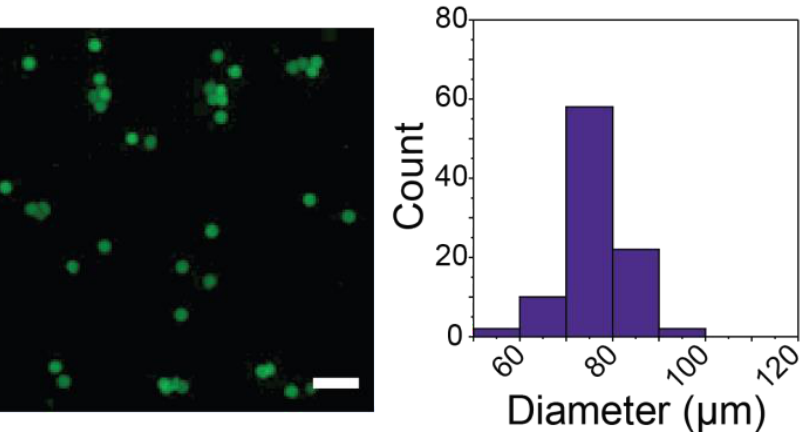
Figure 6. Formation of light-degradable microgels using SPAAC. Homogeneous photodegradable microgels were formed between PEG-4-DBCO and PEG-4-NB-azide and loaded with BSA-AF488 using MFF. Average microgel diameter formed using SPAAC with light-responsive crosslinks was 76.7 ± 6.2 µ m. Scale bar = 200 µ m. Representative images are shown on the left with histograms showing the distribution of diameters on the